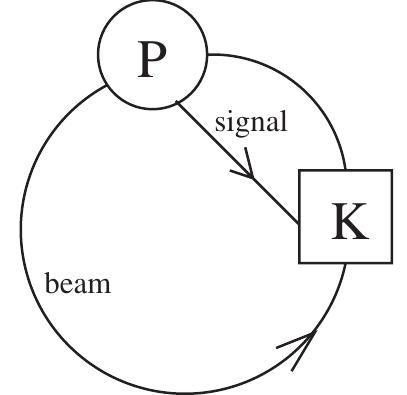
system.*blaskiewicz@bnl.gov †